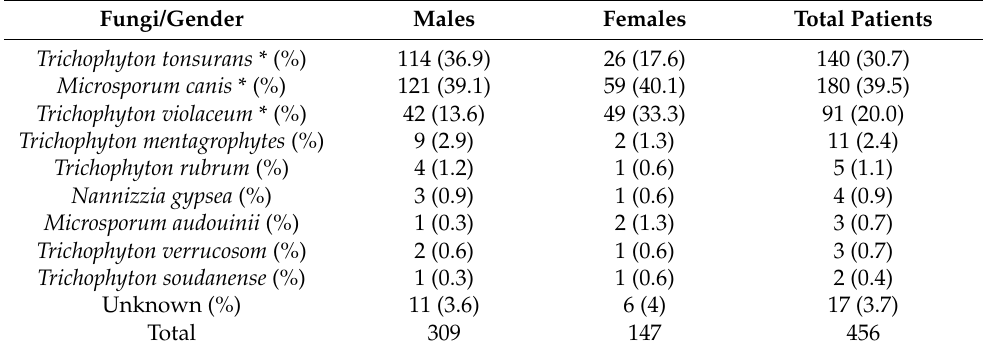
Table 2. Prevalence of main pathogens by